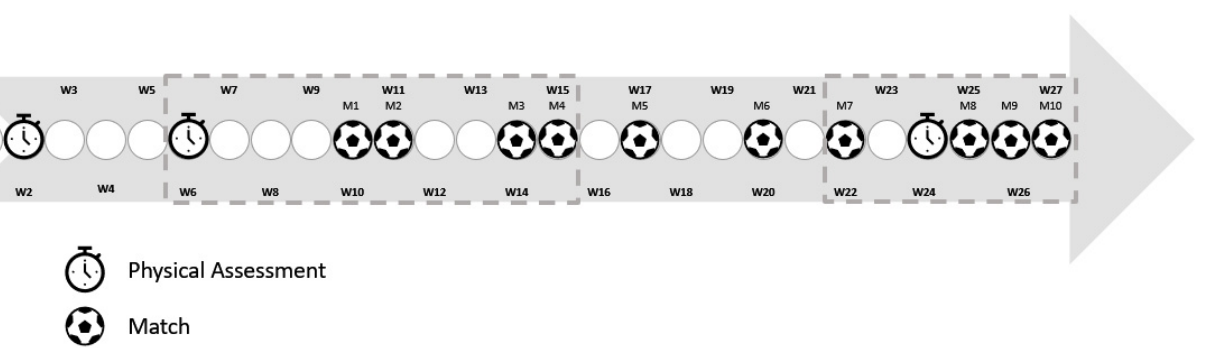
Table 1. Physical fitness assessment (mean ± SD).